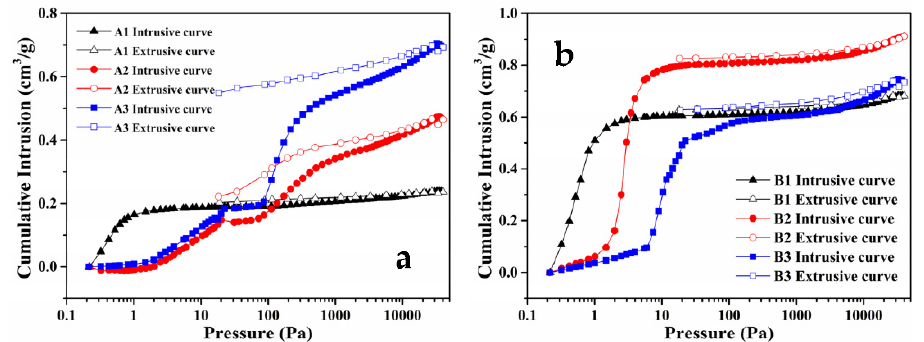
Figure 1. MIP intrusive and extrusive curves of the mudstone ( a ) and coal ( b ) samples under different granule diameter conditions.